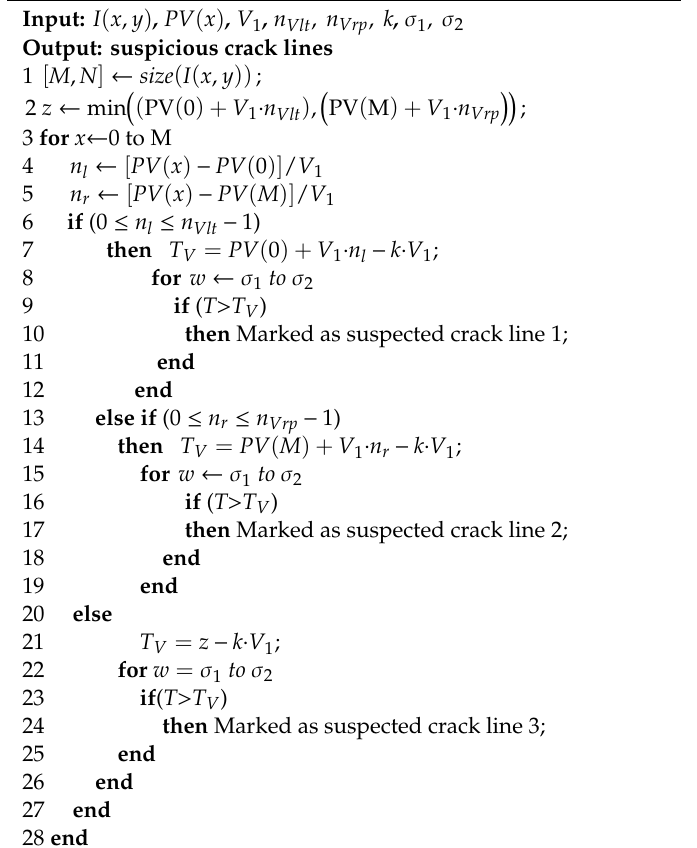
Algorithm 1: DPG algorithm (vertical